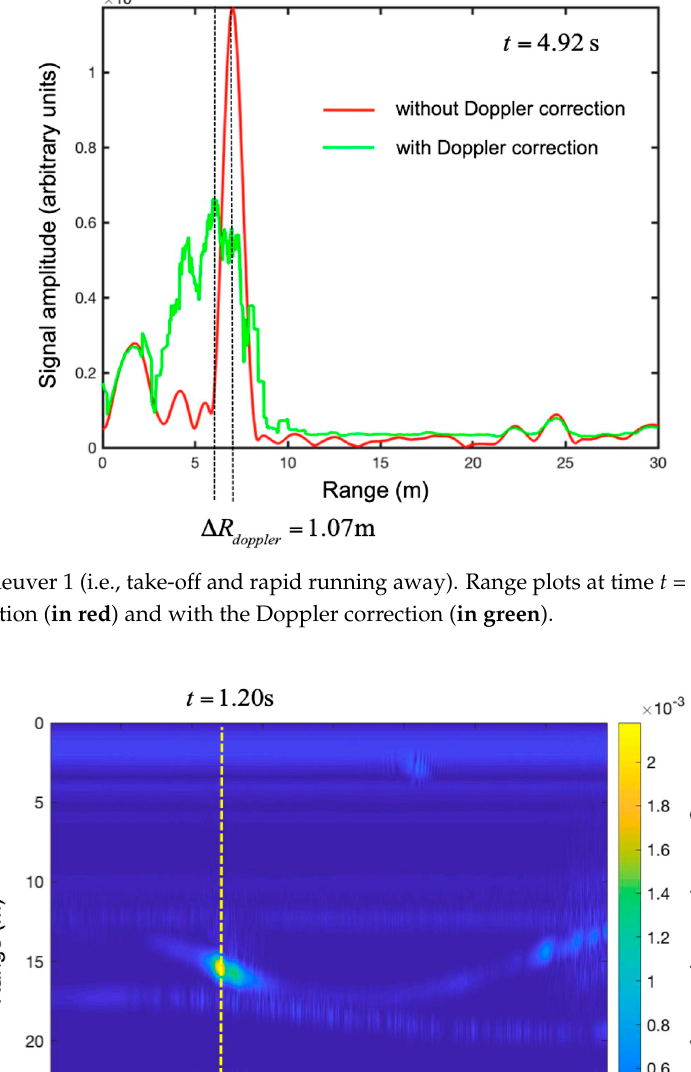
Figure 21. Detection of a small UAV using a SFCW radar. Time-range map without the Doppler correction during maneuver 2 (i.e., rapid take-off).